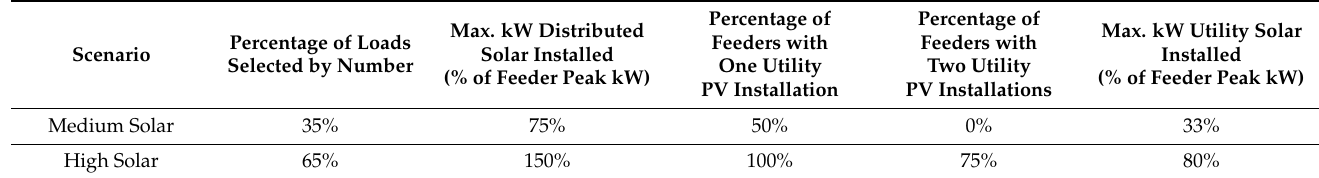
Table 1. Distribution buses with solar installations added in medium and high scenarios.